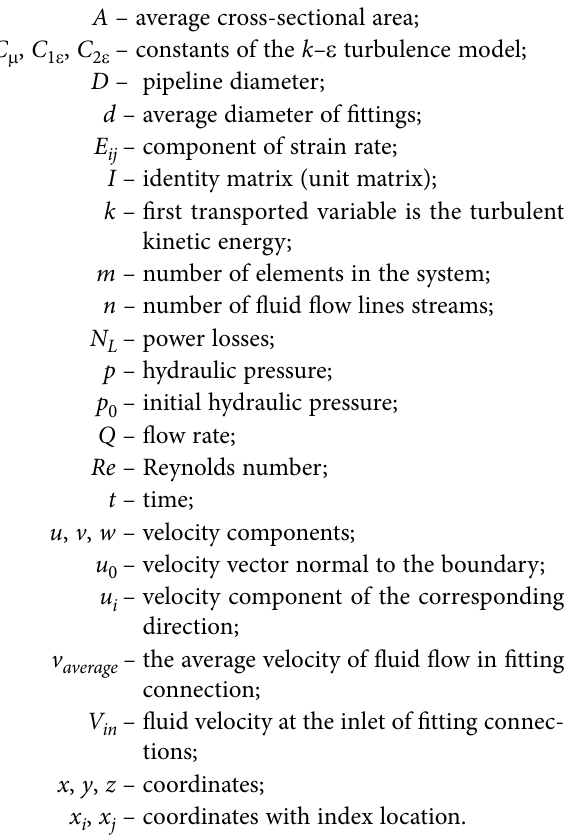
Inside protrusion in HPH Crimp coupling Fitting Figure 1. The typical hydraulic composition of a system (Karpenko, Bogdevičius 2018): a – HPH with fittings; b – part of hydraulics